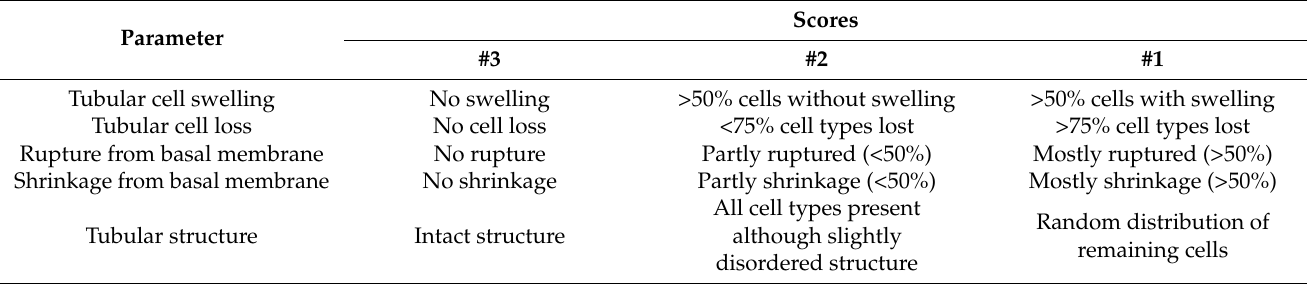
Table 1. Morphological parameters of seminiferous tubules from the testes of red-rumped